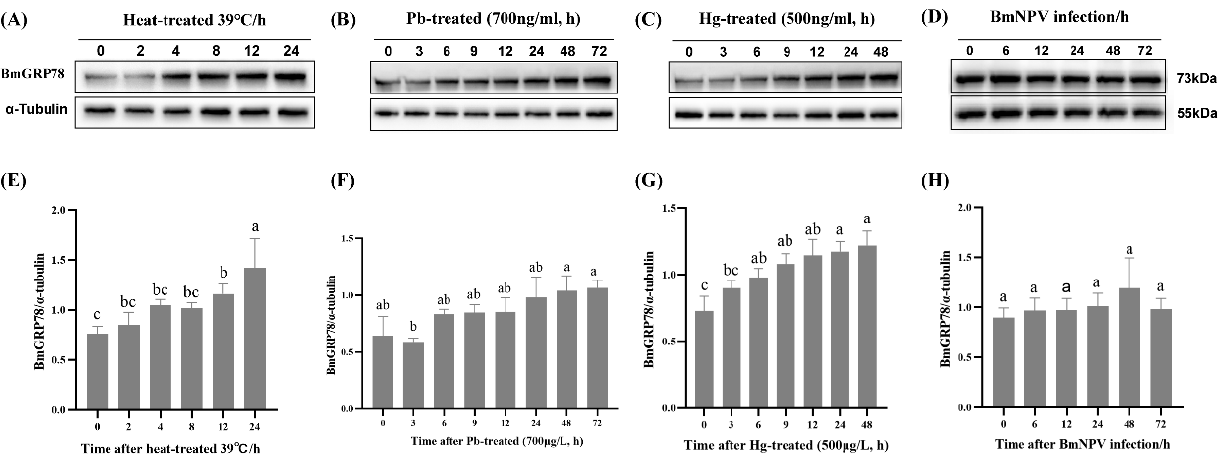
Figure 6. The translational level of BmGRP78 in response to different stress-induced conditions. ( A , E ) Heat-treated, ( B , F ) Pb-treated, ( C , G ) Hg-treated, ( D , H ) BmNPV infection. Bars represent mean ± S.E. (n = 3). Bars with different letters (a, b, and c) are significantly different (one-way ANOVA followed by Tukey’s test, p < 0.05).